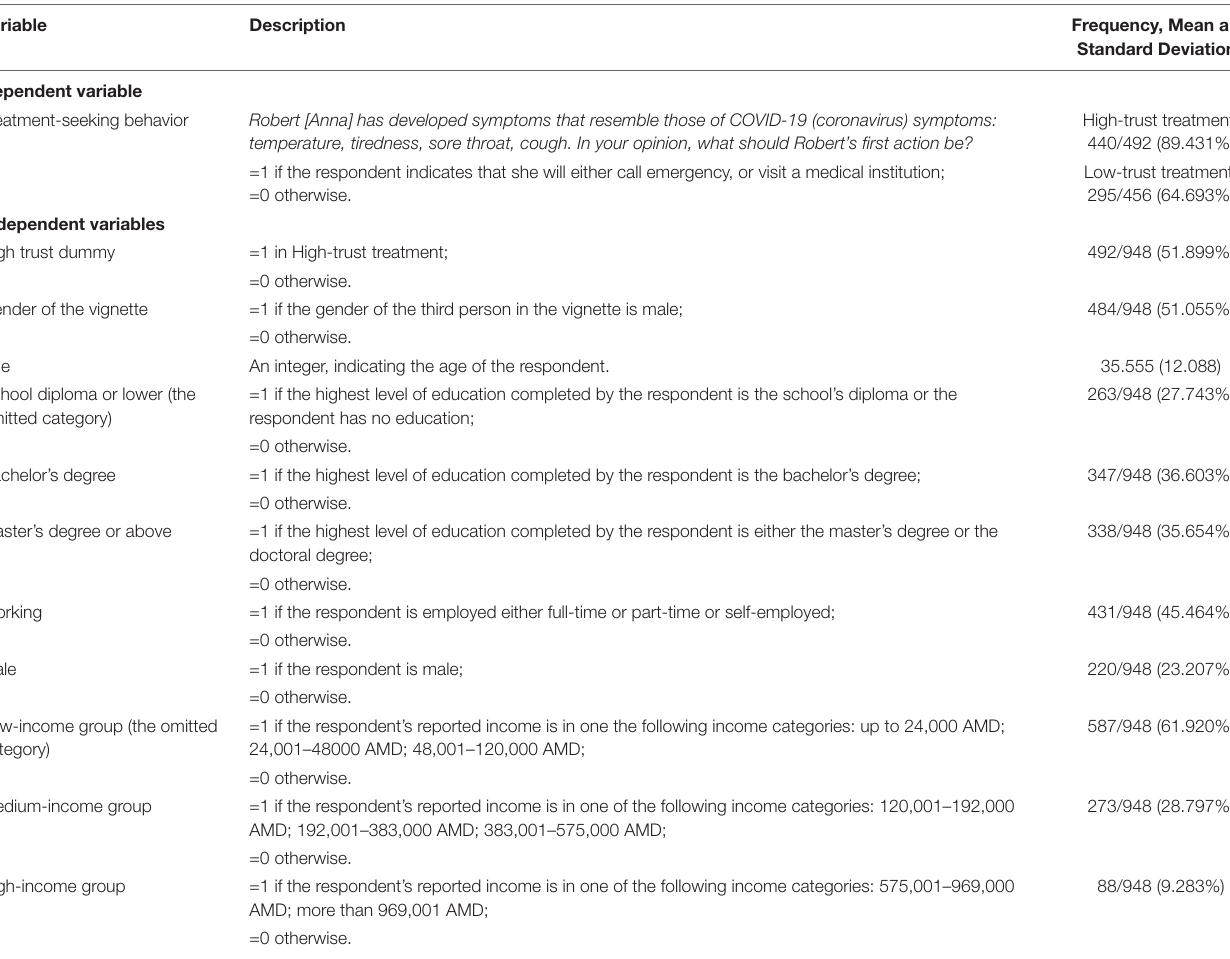
TABLE 3 | Variables and descriptive statistics.